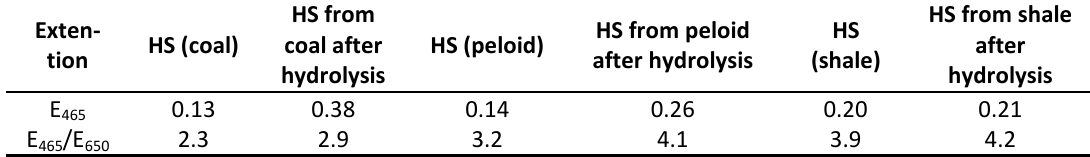
Table 4. Color-input of humic substances